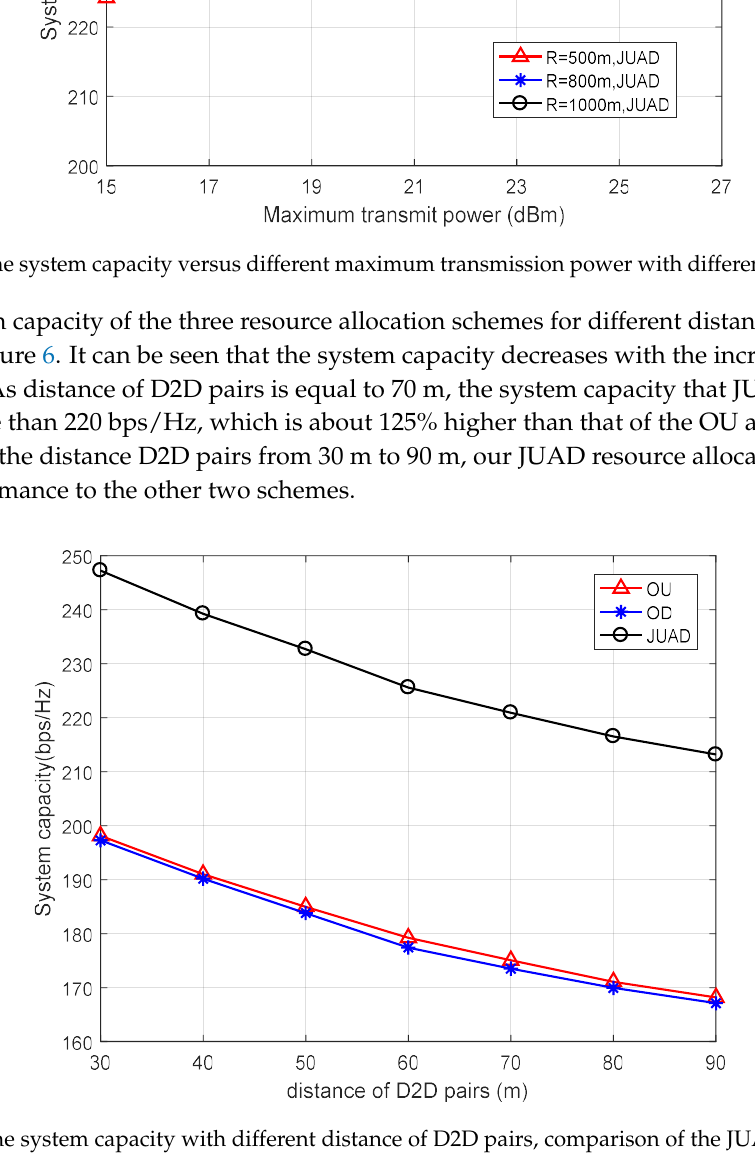
. Figure 7. The system capacity with different distance of D2D pairs in terms of different maximum transmission power. Figure 8 displays the output performance of the proposed JUAD algorithm versus different cell radius. The same user density is assumed to be for both